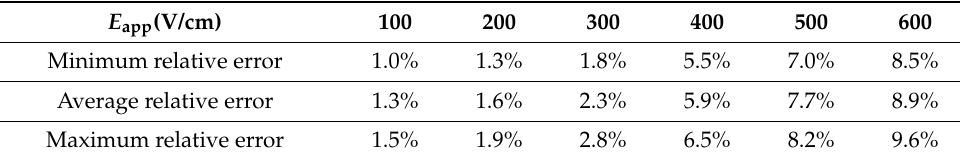
Figure 16. Time averaged cross-sectional average velocity at the center of the constriction microchannel ( x = 0): ( a ) Average velocity, ( b ) comparison of average velocity (with deviation) and Helmholtz–Smoluchowski velocity (lines). Table 1. Relative error between the Helmholtz–Smoluchowski velocity and the average velocity from the full mathematical model.